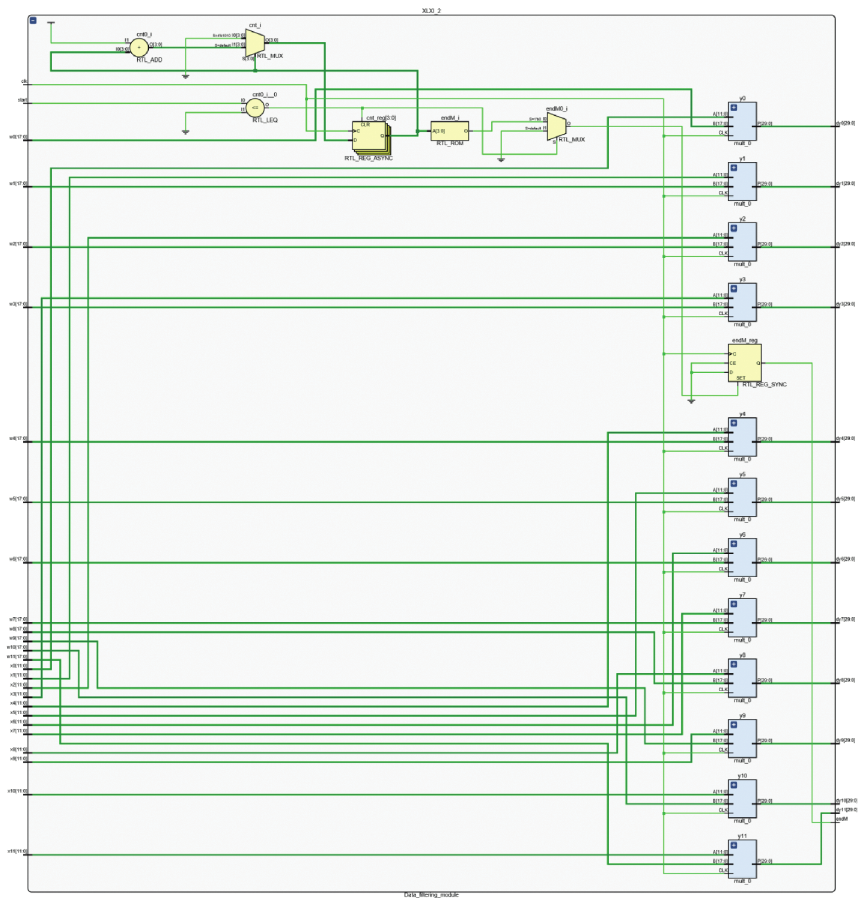
Figure 12: Integrated circuit diagram of the data filtering